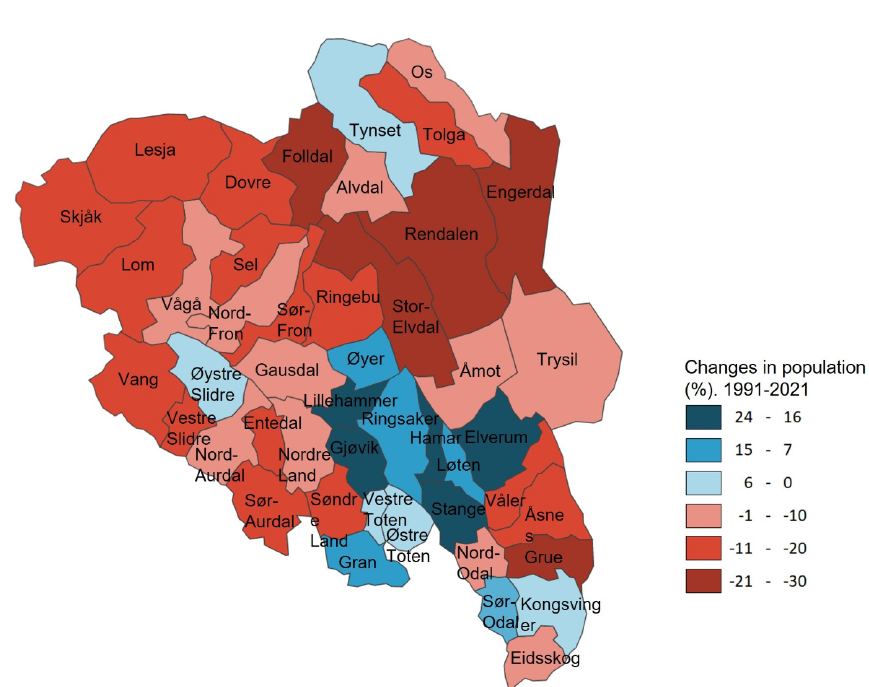
Fig. 1. Changes in population (%) in municipalities in Innlandet 1991–2021. (Source: Statistics Norway